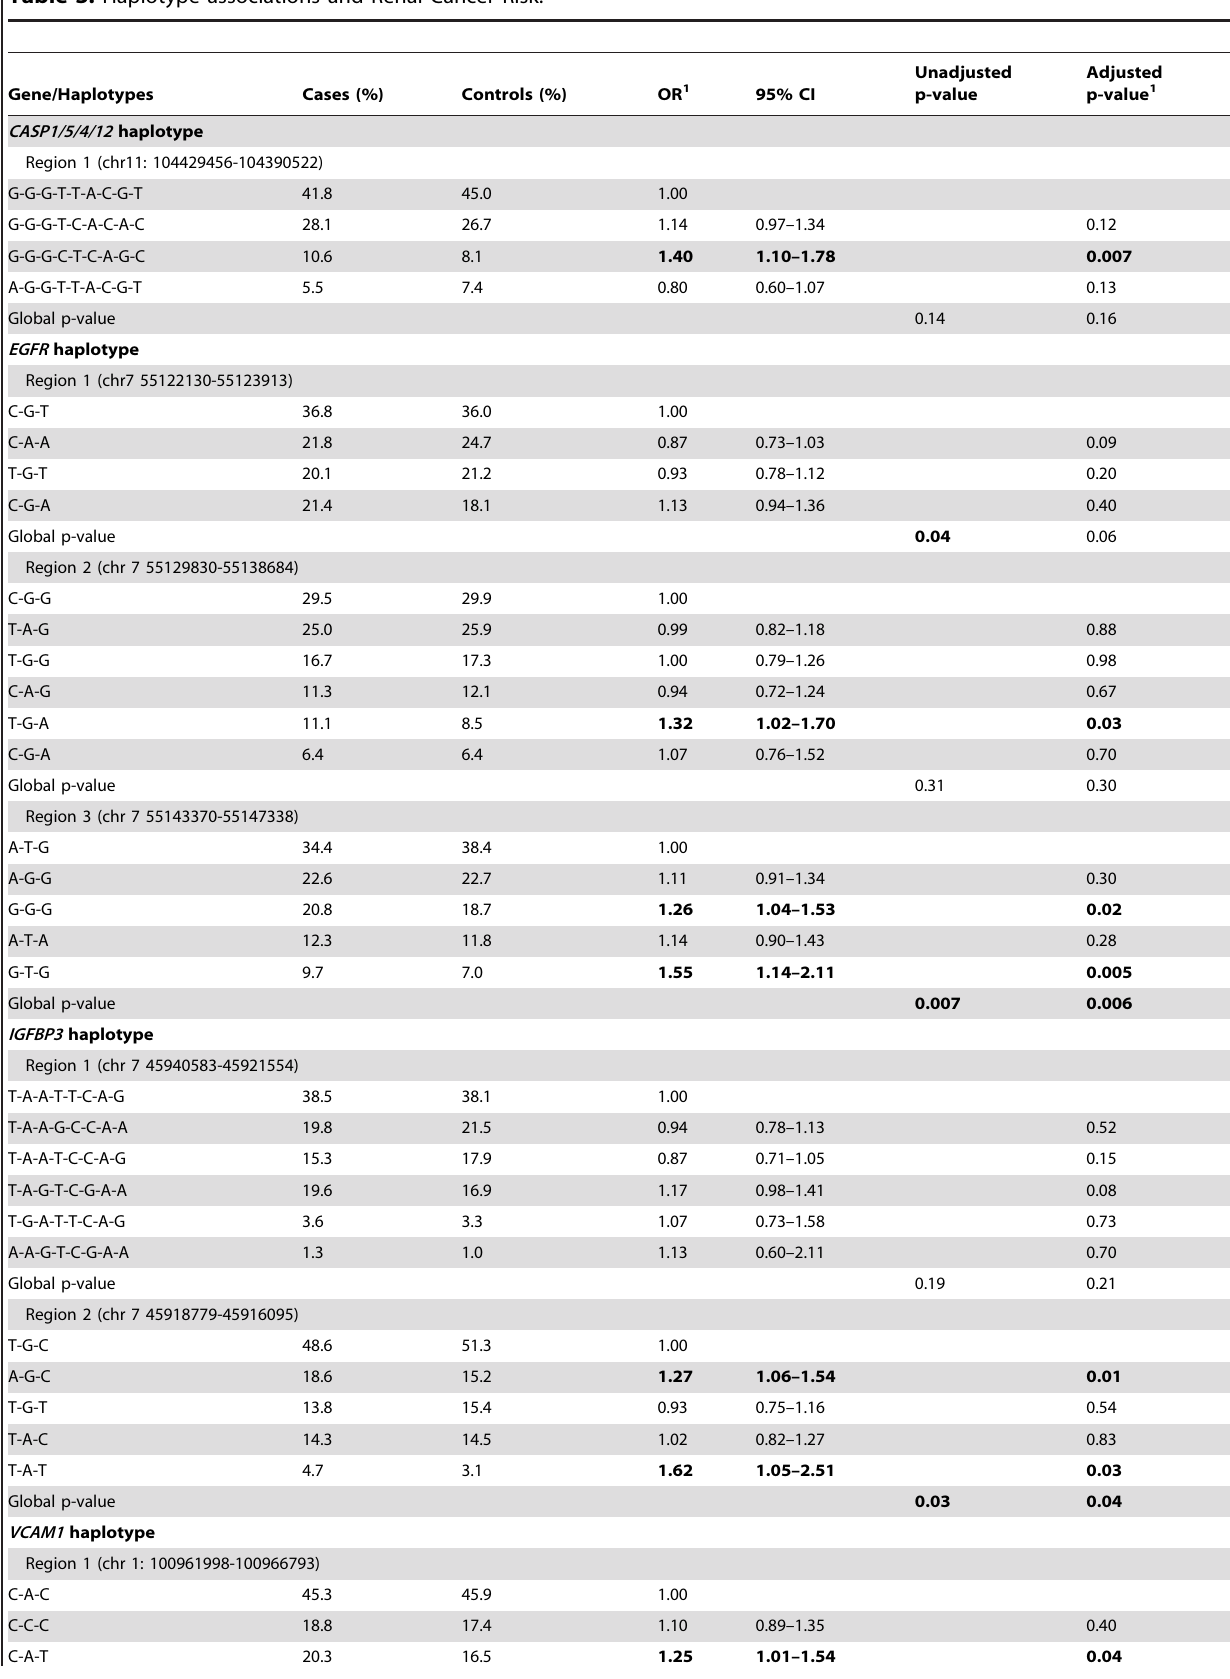
Table 3. Haplotype associations and Renal Cancer Risk.